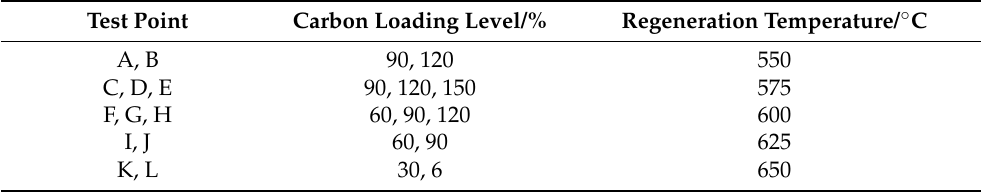
Table 4. Design of experimental